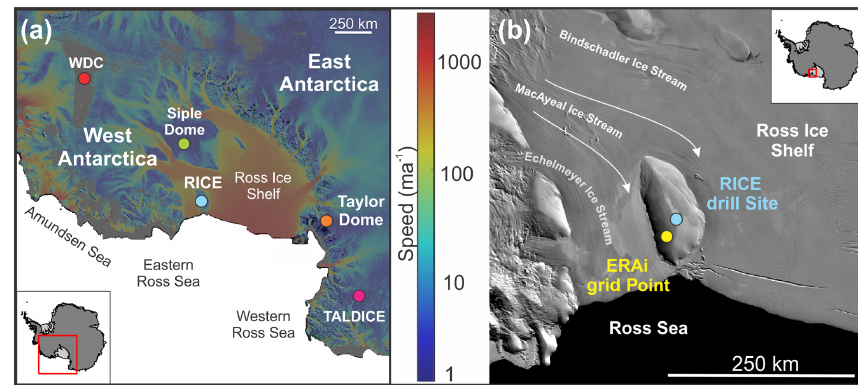
Figure 1. (a) Overview map of the Ross Sea region and eastern West Antarctica. Antarctic ice velocity derived from the Advanced Land Observing Satellite (ALOS) with the Phased Array type L-band Synthetic Aperture Radar (PALSAR), the European Space Agency (ESA) Envisat Advanced Synthetic Aperture Radar (ASAR), European Remote Sensing (ERS) satellites, ERS-1 and 2, and the the Canadian Space Agency (CSA) RADARSAT-1 and 2 satellite radar interferometry colour-coded on a logarithmic scale (Rignot et al., 2011). Coloured dots indicate the locations of ice core drilling sites used in this paper: RICE (blue), West Antarctic Ice Sheet Divide ice core (WDC; red), Siple Dome (green), TALDICE and Talos Dome TD96 (purple), Taylor Dome (orange). (b) Overview map of Roosevelt Island derived from the Moderate-resolution Imaging Spectroradiometer (MODIS) satellite images (Scambos et al., 2007). The maps were created using the Antarctic Mapping Tool (Greene et al., 2017). The coloured dots indicate the location of the RICE drill site (blue) and the nearest ERA-Interim (ERAi) grid point